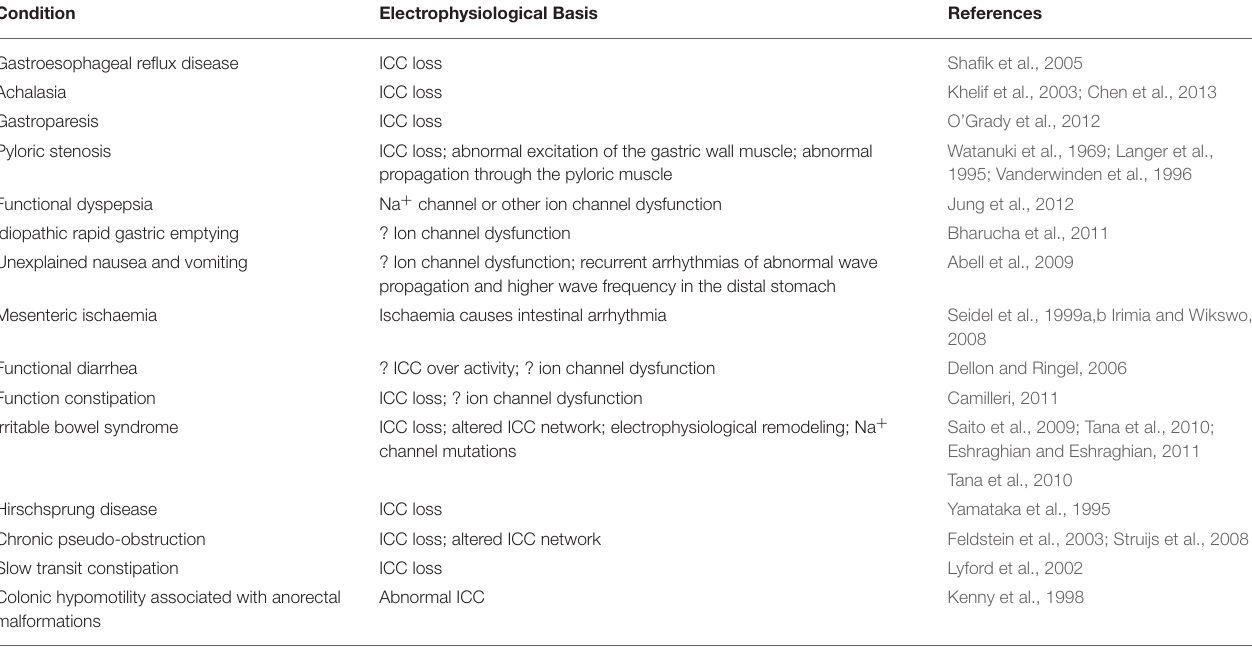
TABLE 1 | Conditions caused by abnormal gastrointestinal electrophysiology and their proposed